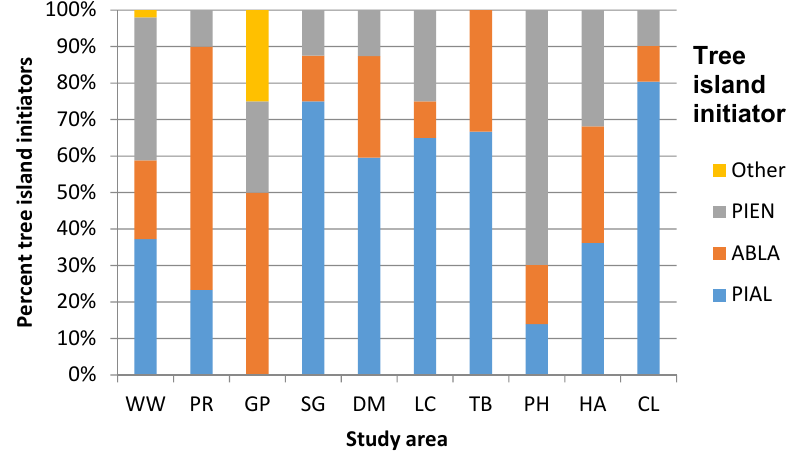
Figure 5. Relative proportional abundance of whitebark pine as a tree island initiator, as inferred by its leading windward position in tree islands, within each study area. See Table 3 for conifer species listed under “Other”, and Figure 3 for conifer species abbreviations and study area abbreviations.